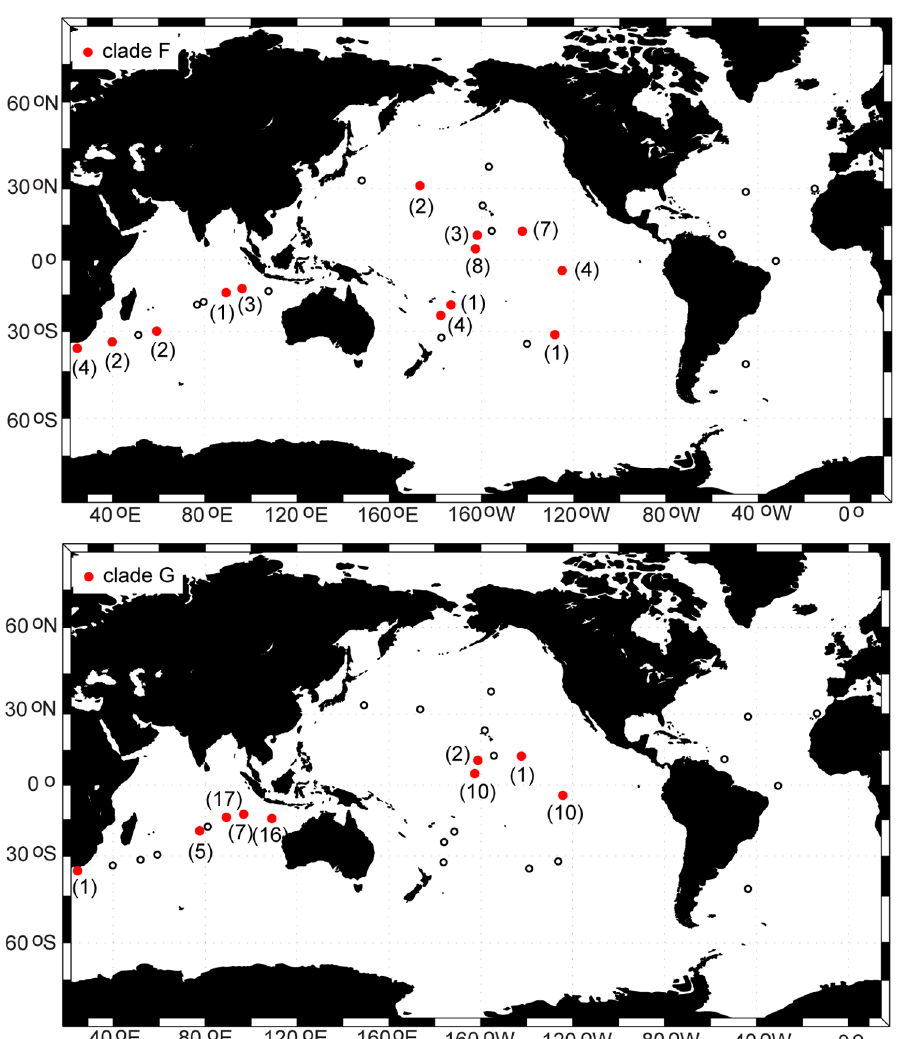
Figure 8. Distribution map for Indo-Pacific clades F (top panel) and G (bottom panel). The number of specimens (n) for each site is given in parentheses beside the symbol. Small, open circles indicate sample locations that did not include any specimens of this clade